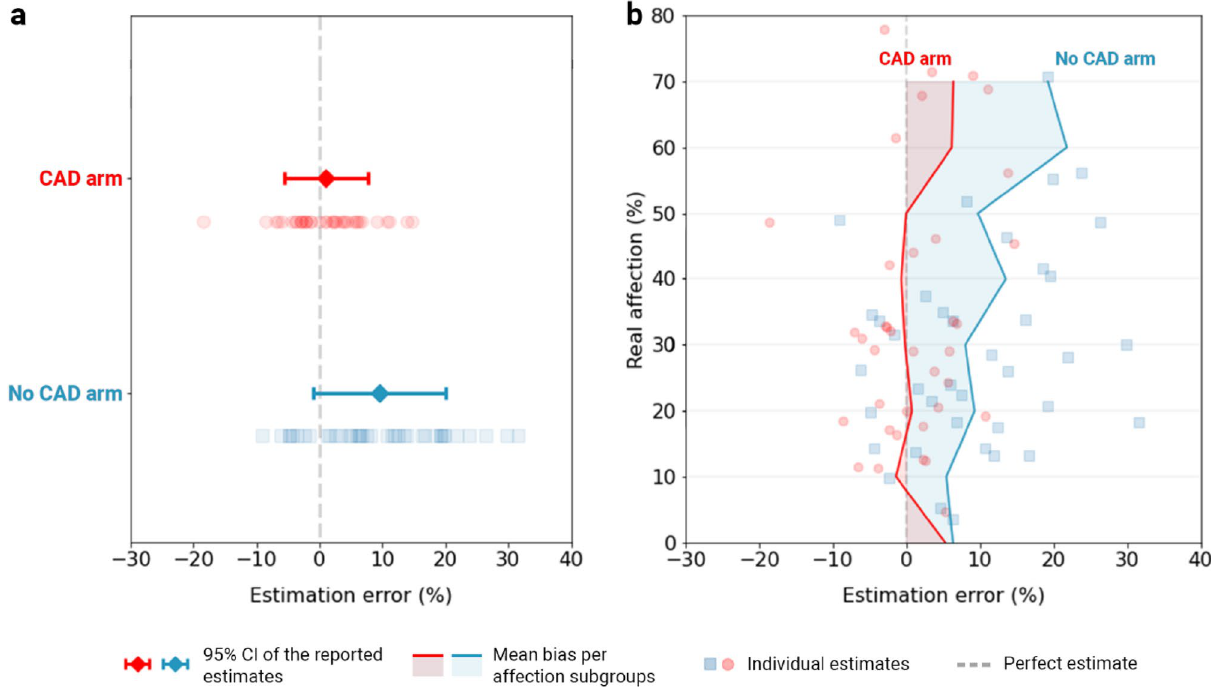
Figure 6. Measured estimation differences between the two arms. ( a ) Mean overestimation differences between the two arms. ( b ) Bias disposition across severity